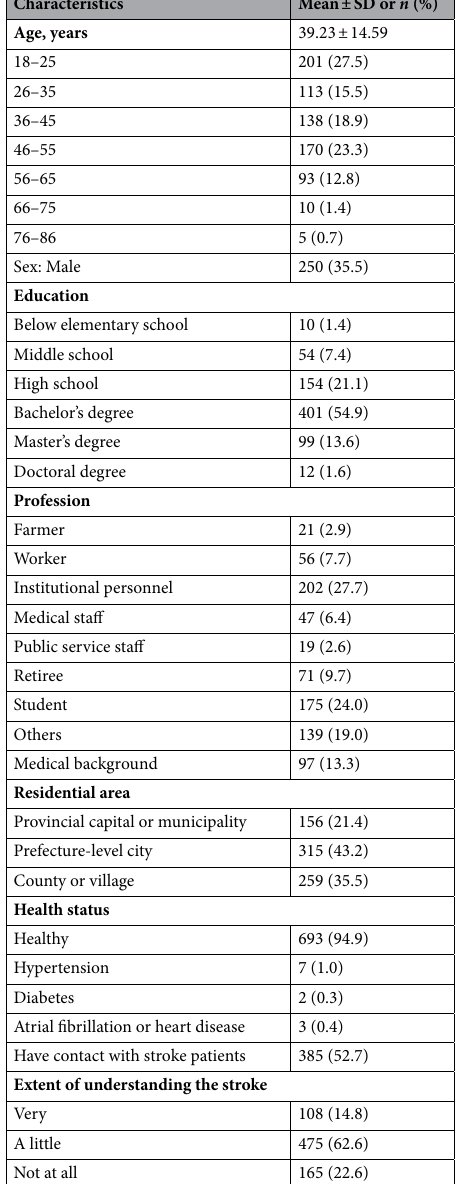
Table 1. Participants’ demographics (N =